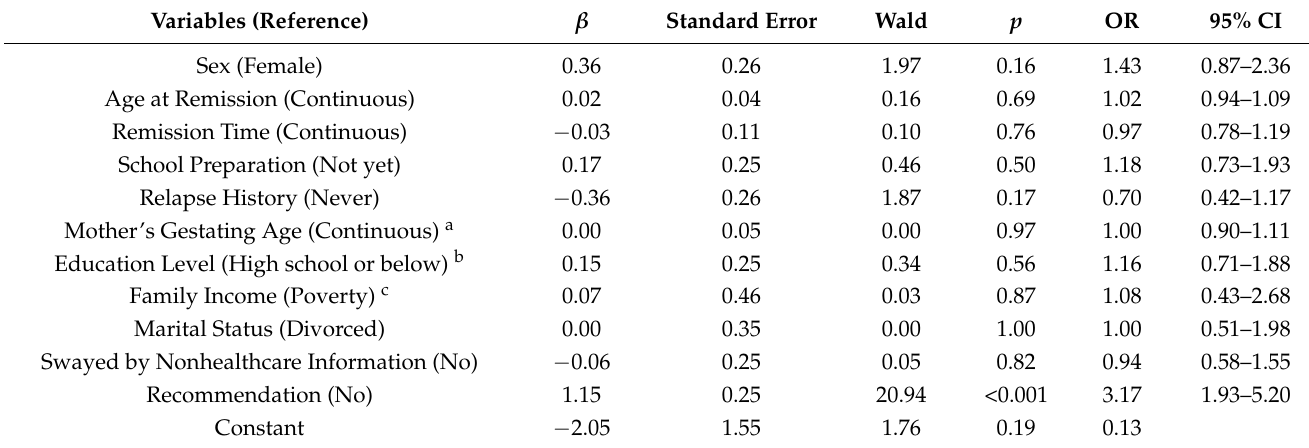
Table 2. Multivariable logistic regression of vaccine acceptance in CALLS families.